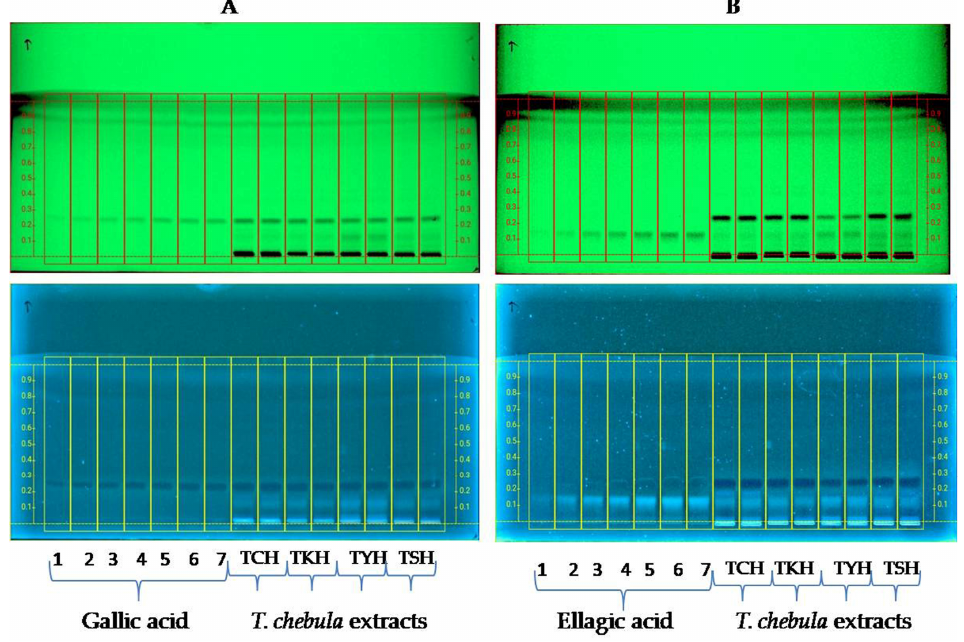
Figure 1. HPTLC chromatogram of increasing concentrations of gallic acid ( A ) and ellagic ( B ) and hydroalcoholic extracts of T. chebula fruits (TCH, TKH, TYH, and TSH) at 254 nm and 366 nm. 2.4. Total Phenolic, Total Flavonoid, and Antioxidant Activity of T. chebula Extracts In order to calculate the quantity of polyphenols and flavonoids present in the extracts, gallic acid and quercetin standards were used to derive the calibration curve, y = 0.010x + 0.251, R2 = 0.983 and y = 0.016x − 0.096, R2 = 0.963, for the determination of TPC and TFC, respectively. TPC and TFC were expressed in terms of gallic acid equivalent and quercetin equivalent per gram of dry weight of extract, respectively. TPC was found to be highest in TYH (304.56 ± 1.23 GAEmg/g ext), while the highest TFC was observed in TCH (8.98 ± 0.35 QEmg/g ext). The free radical scavenging or antioxidant capacity of the four T. chebula extracts was assessed using the DPPH and ABTS assays. The results were compared with Trolox (TC) and ascorbic acid (AC) standards. Figure 2 depicts the IC 50 values (concentration of extracts that cause 50% of free radical scavenging activity) for the DPPH and ABTS assaysand TPC and TFC of the extracts. TYH was found to possess the highest activity in both DPPH and ABTS assays with the most negligible IC 50 value, as shown in Table 3. The highest concentration, 500 µg/mL, of TYH showed 85% free radical scavenging activity in the DPPH assay, and 100 µg/mL of TYH showed 90% activity in the ABTS assay. The IC 50 value of TYH for the DPPH and ABTS assays (12.16 ± 0.42 and 7.80 ± 0.23 µg/mL) was found to be lower than that of Trolox (18 ± 0.44 and 10.15 ± 0.24 µg/mL). The free radical scavenging activity was in the order TCH < TSH < TKH < TYH < TC < AC.